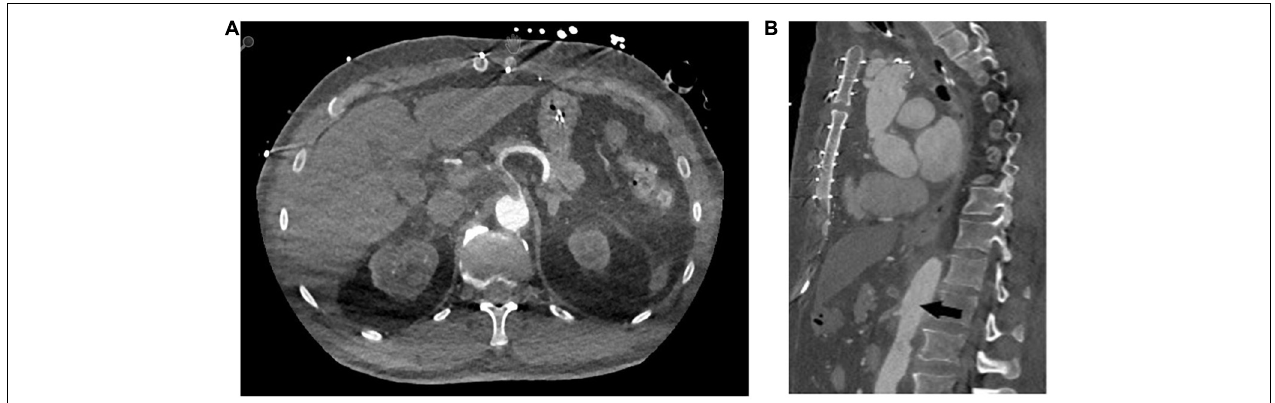
FIGURE 2 | Representative computed tomography angiography images of distal embolisation of the in-stent thrombi to the coeliac trunk (A) axial plane (B) sagittal plane.